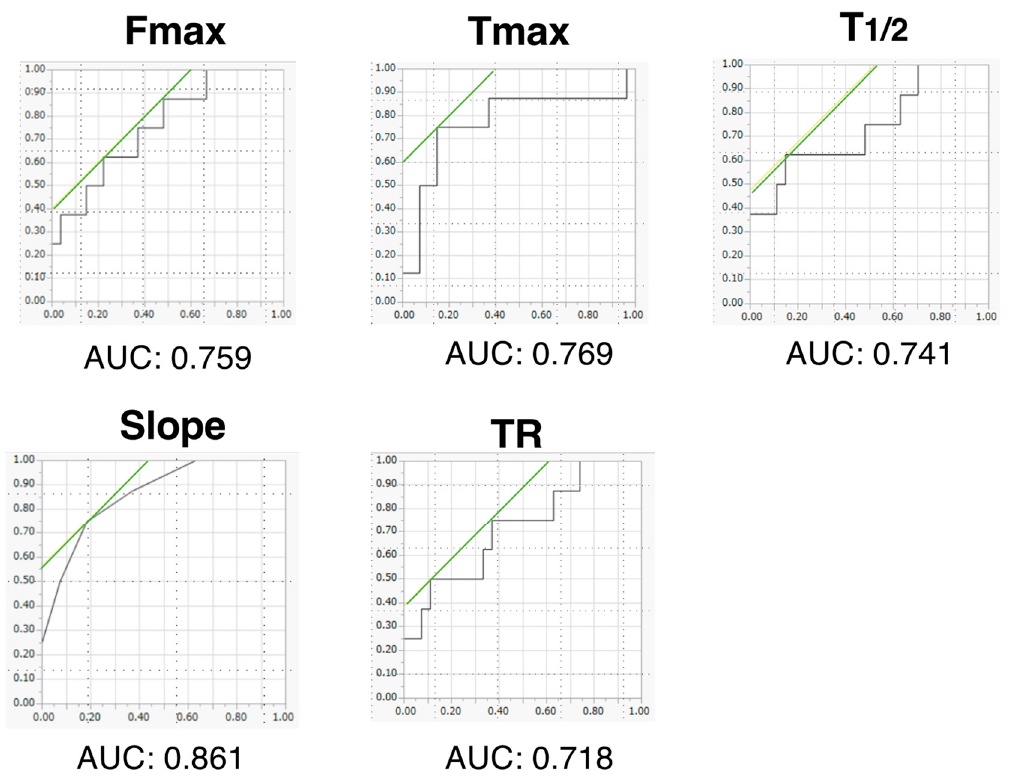
Figure 6. Comparison of five ICG fluorescence-related parameters between AL group and non-AL group.